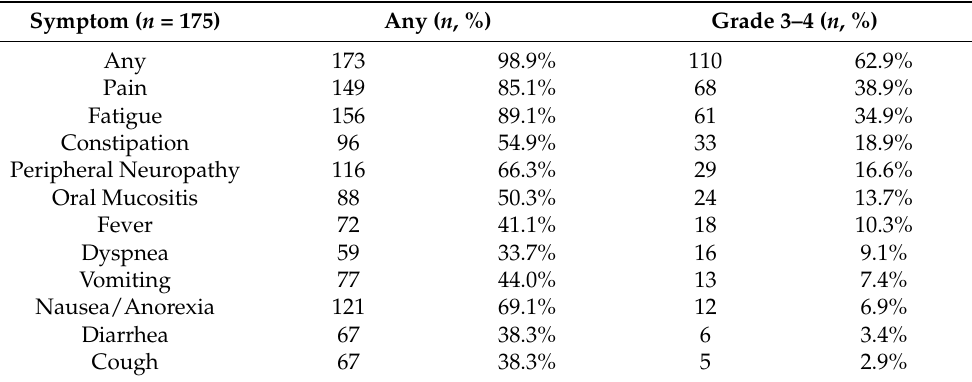
Figure 2. Trend test of symptom score standardized means and global impression of change response. Table 4. Symptoms reported by participants receiving